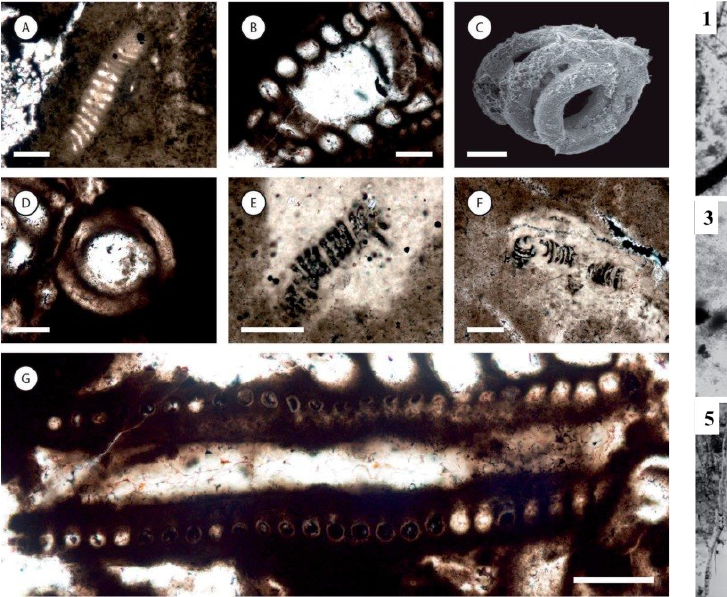
Fig. 3. 1-8. “Zavkhan biota” from the Ediacaran Tsagaan-Olom phosphate-bearing Formation of the Zavkhan basin, western Mongolia. 1-Tyraso- forma Archaeooides